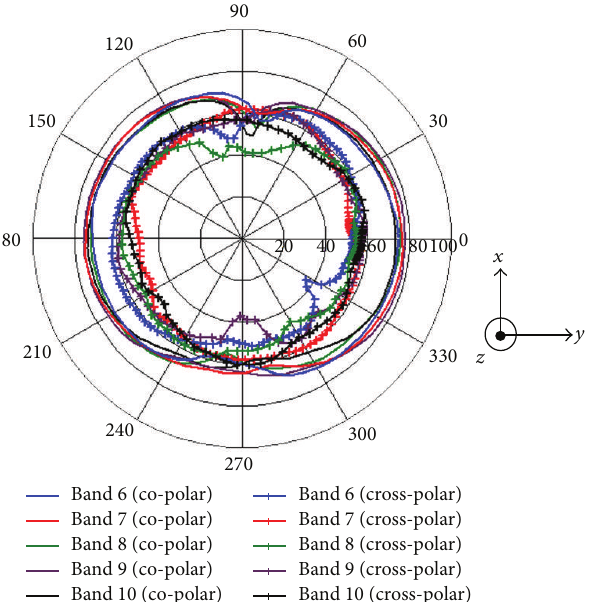
Figure 10: Measured E-Plane radiation patterns (co-polar & cross- polar) at operating frequency, 𝑓 , for TMFDB25 with stubs 1, 2 at bands 11 to 15.